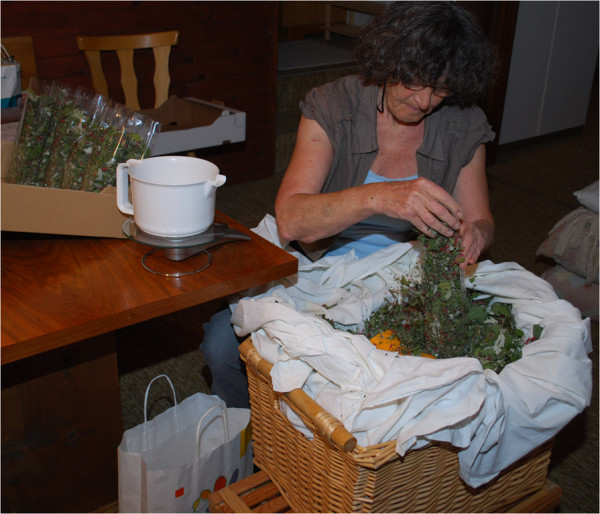
 PackingBergteetea blends in 30 gram portions (Photo: Susanne Grasser).